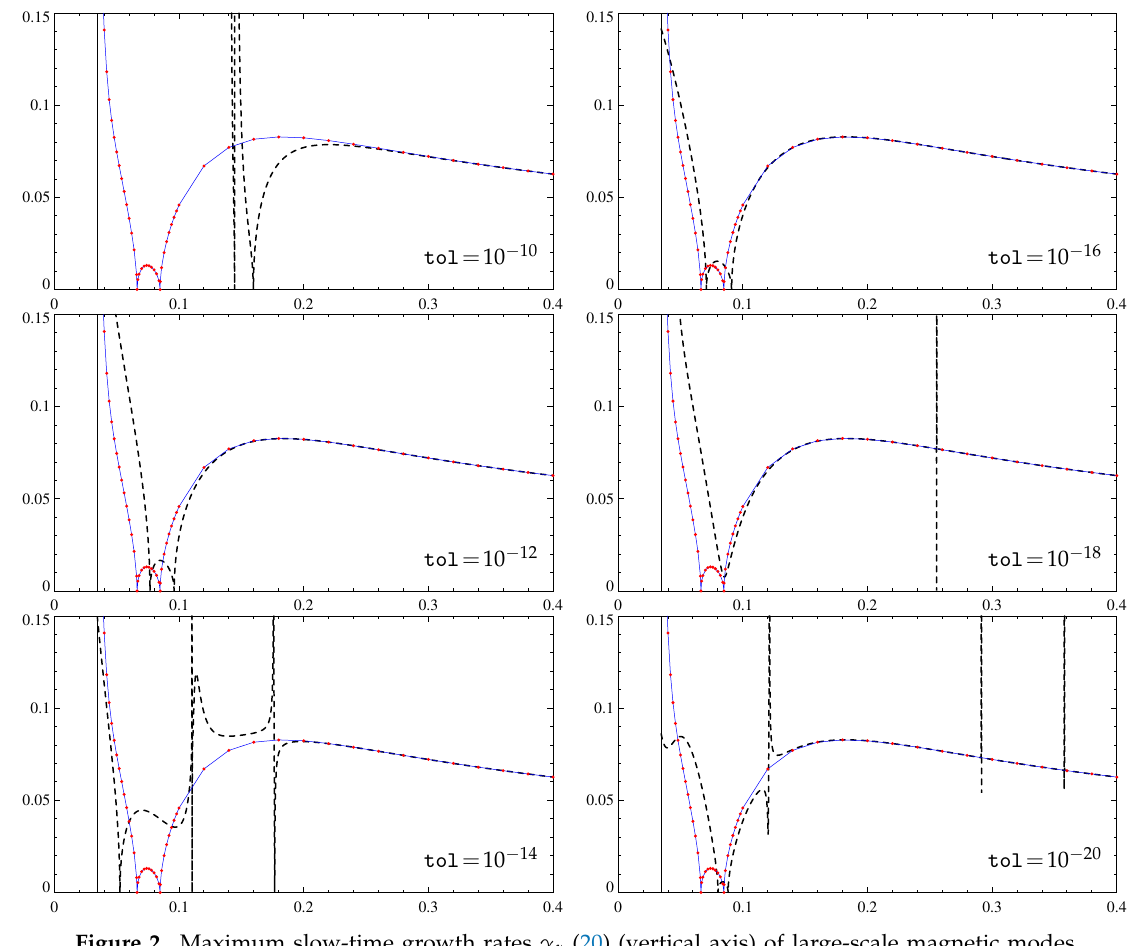
Figure 2. Maximum slow-time growth rates γ α (20) (vertical axis) of large-scale magnetic modes generated by the α -effect as a function of the molecular diffusivity η (horizontal axis), computed using the α -effect tensor, Padé-approximated by the algorithm in [35] for a varying tolerance tol . Thin solid line: the dependence determined by computation of γ α at individual η values (red solid circles) by spectral methods (resolution 64 3 Fourier harmonics), thick dashed line: the approximate